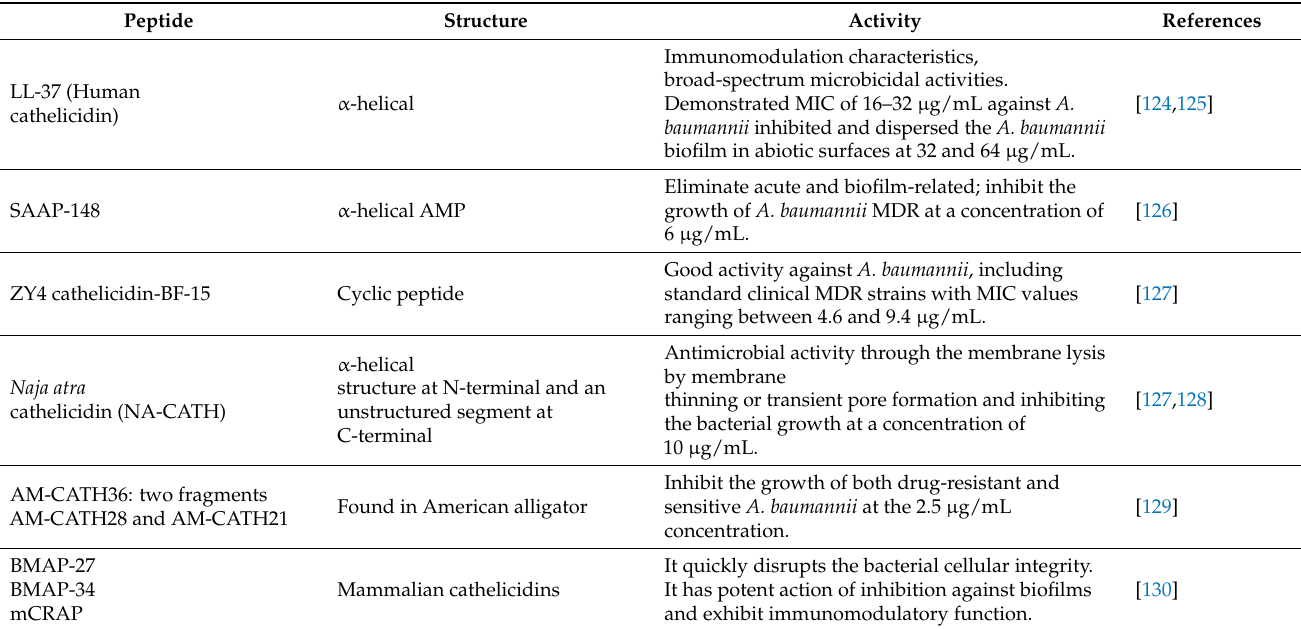
Table 3. Cathelicidins used for the treatment of A. baumannii